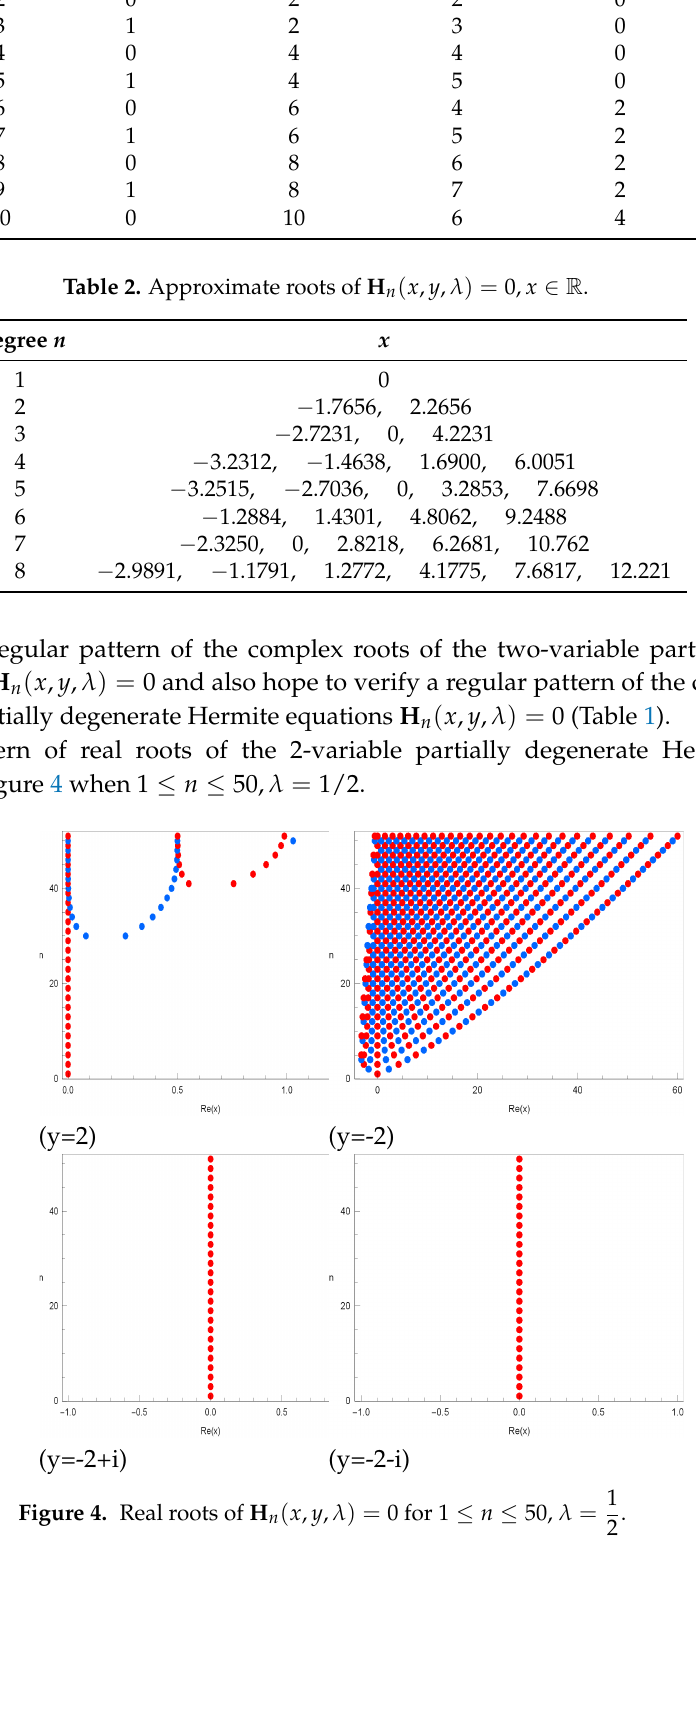
Figure 4. Real roots of H n ( x , y , λ ) = 0 for 1 ≤ n ≤ 50, λ =